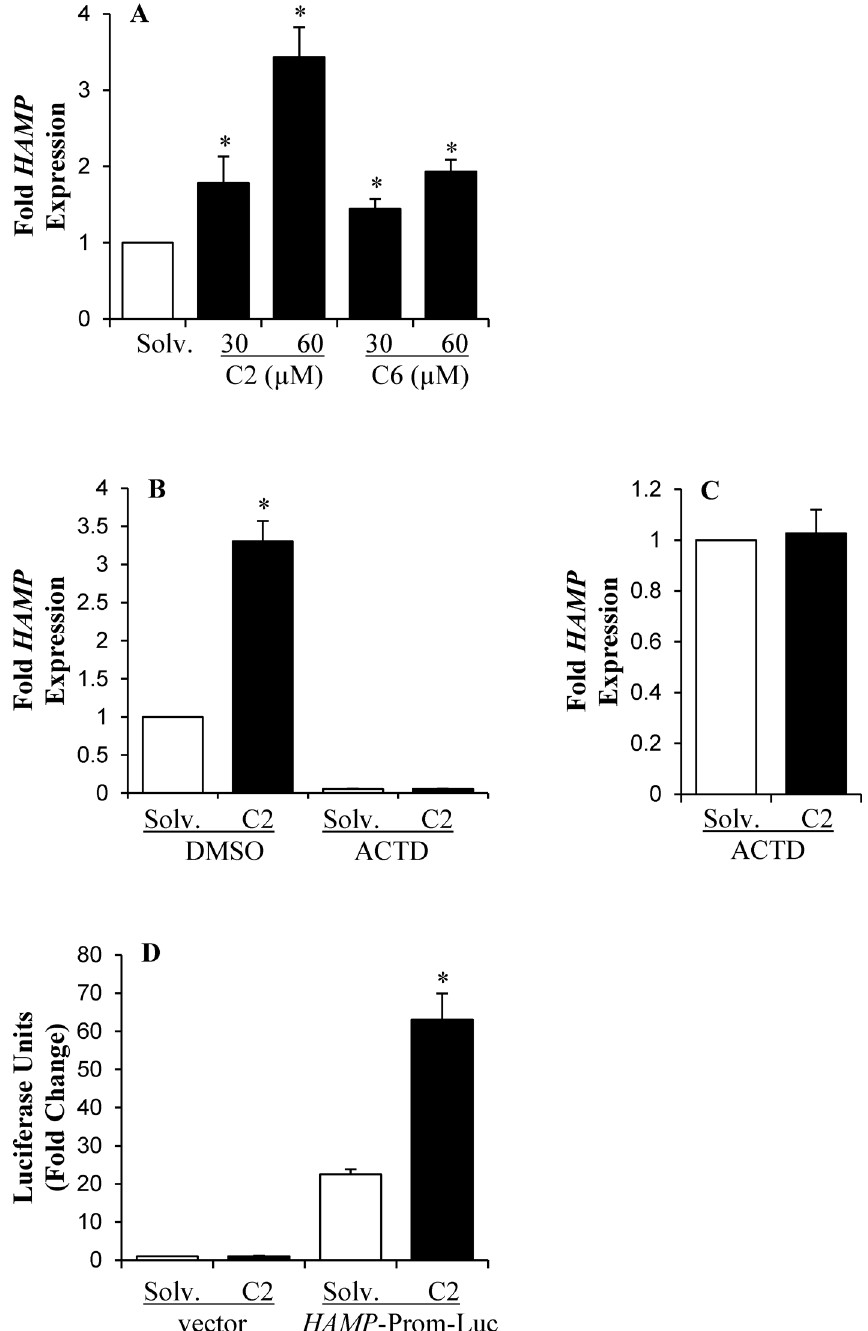
Fig 1. Ceramide analogs induced HAMP transcription. ( A ) HAMP mRNA expression in HepG2 cells, treated with 30 μ M or 60 μ M of C2 and C6 ceramide or solvent (solv.) control for 8 hours, was determined by Taqman qPCR, as described in experimental procedures. HAMP mRNA levels in ceramide-treated cells was expressed as fold change of that in solvent-treated cells. ( B ) HepG2 cells were treated with 60 μ M C2 ceramide or solvent in the presence of either 1 μ g/ml actinomycin D (ACTD) or DMSO as control. HAMP mRNA expression, determined by qPCR, in treated cells was calculated as fold change of that in control cells, incubated with solvent and DMSO. ( C ) The effect of ACTD on HAMP up-regulation induced by ceramide was shown by calculating HAMP expression in C2 ceramide-treated cells as fold change of that in cells treated with solvent. ( D ) HepG2 cells, transfected with pGL-3 basic vector harboring 0.6kbp HAMP promoter ( HAMP - Prom-Luc) or empty pGL-3 basic vector (vector), and pRL-SV40 plasmid as control for transfection